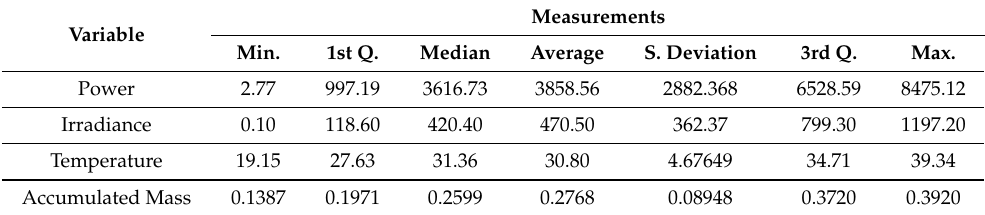
Table 1. The summary of the measurements.